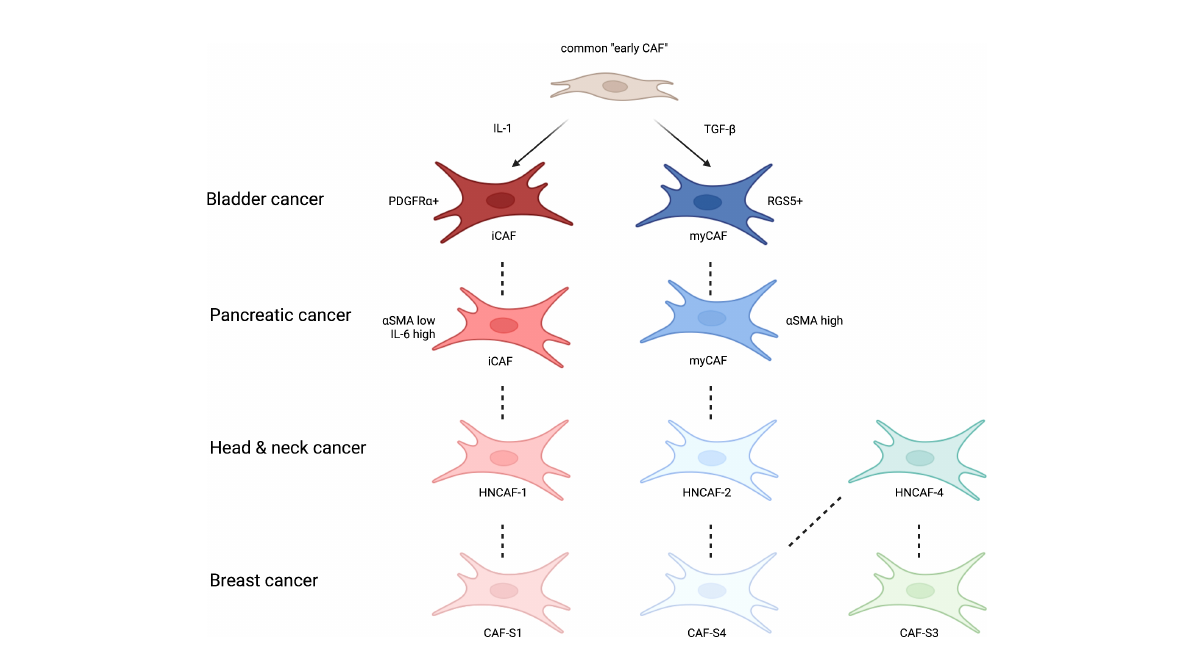
FIGURE 2 A simpli fi ed schematic of CAF subtypes centred around bladder cancer and their similarity with CAFs reported in other common cancers. Derived from a common CAF progenitor (25) and activated by IL-1 and TGF b (26), in bladder cancer in fl ammatory CAFs (iCAFs) and myo fi broblast CAFs (myCAFs) are delineated by PDGFR a and RGS5 (56). These CAF subtypes and others have been described in other common cancers, such as pancreatic (24), head and neck (55) and breast (53) with their own respective protein markers or transcriptional pro fi les. Figure adapted from Obradovic et al., 2022. Figure created with